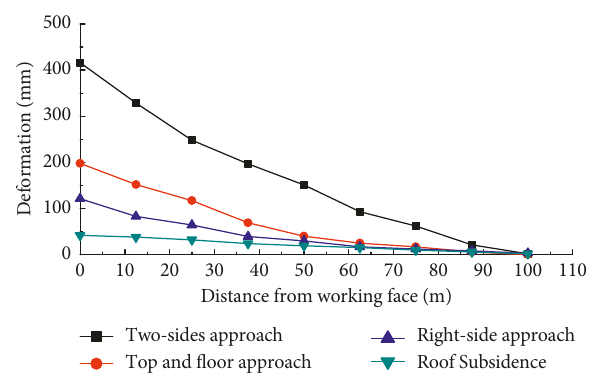
Figure 13: Deformation of conveyor roadway cross section at No. 7 measuring point of J 16-17 -24030 working face.